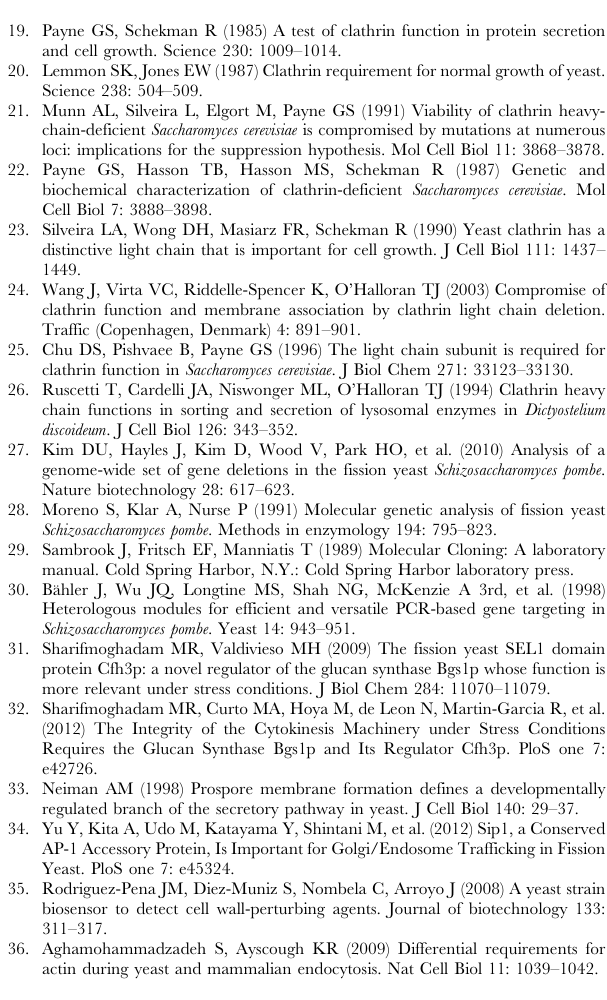
Figure S2 41X HAclc1 cells do not mis-sort Cpy1p to the cell surface. Detection of secreted Cpy1p by Western dot-blot analysis in the indicated strains grown in minimal medium